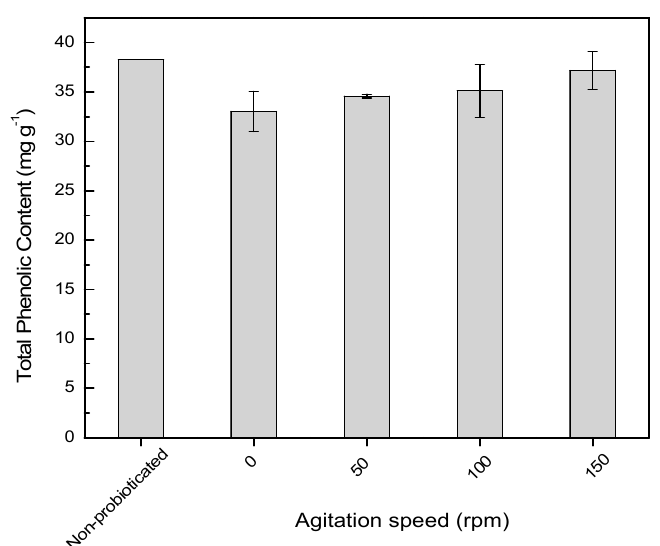
Figure 2. Phenolic content of non-probioticated and probioticated pomegranate juice for 24 hours at different agitation speeds. Means of total phenolic content at different agitation speeds are not significantly different.